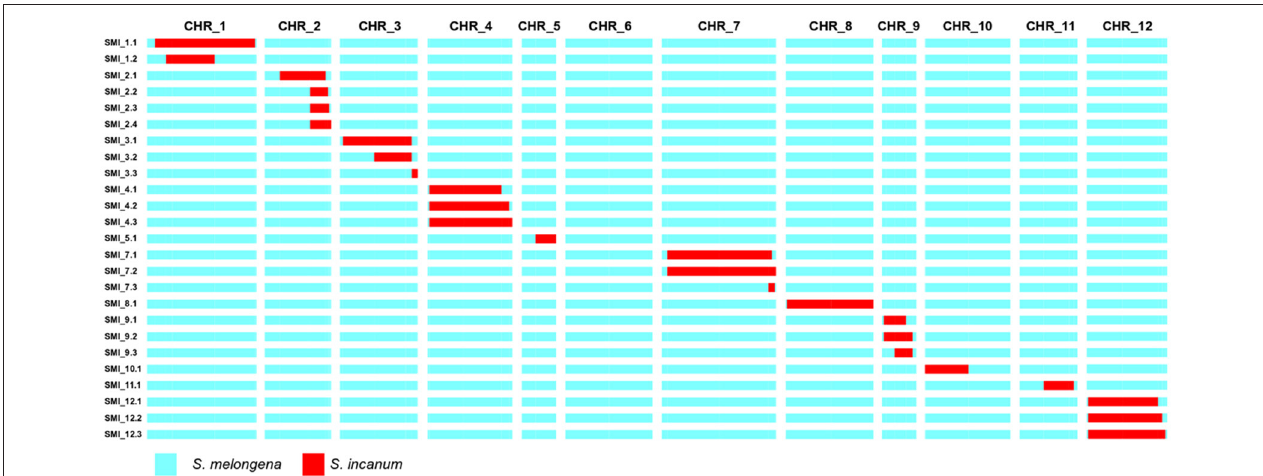
FIGURE 4 | Graphical genotypes of ILs developed using Solanum incanum MM577 as the donor parent in the genetic background of S. melongena AN-S-26. The first row indicates the chromosome number and the first column the IL code. Homozygous introgressions of the donor parent are depicted in red, while the genetic background of the recipient parent is depicted in